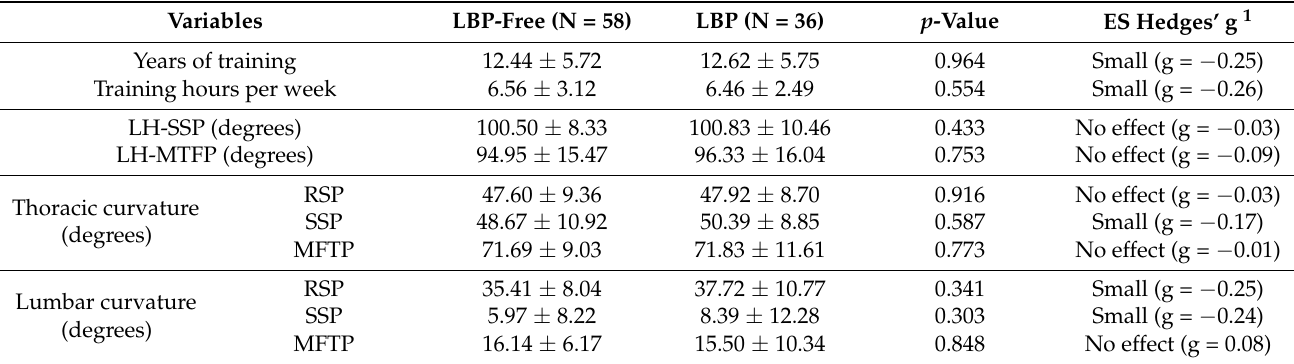
Table 5. Results of the different variables evaluated in competitive amateur athletes with a history of low back pain (LBP) or without